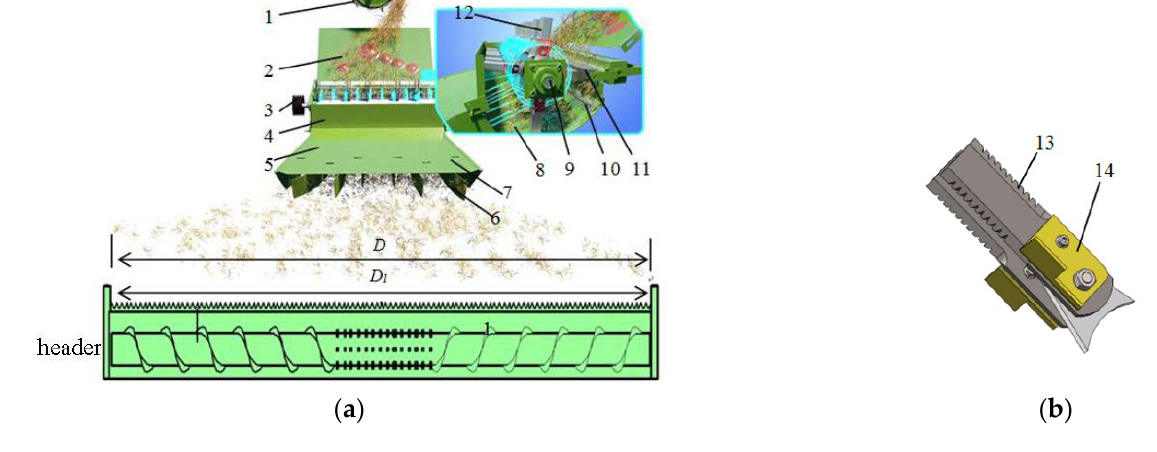
Figure 1. Structure diagram of the SCTD. ( a ) Overall structure and renderings; ( b ) structure diagram of moving knife combination. Note: (1) threshing drum; (2) grass receiving plate; (3) pulley; (4) crushing device; (5) TD; (6) baffle; (7) throwing shell; (8) CC; (9) crushing knife shaft; (10) second-level fixed knife; (11) first-level fixed knife; (12) moving knife combination; (13) moving knife; (14) WB; D is the throwing width, m; D 1 is the header width, m.